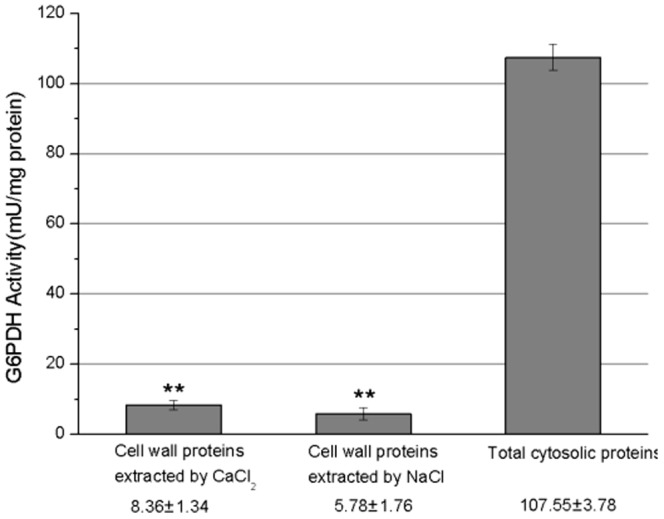
Evaluation of purity by the G6PDH activity in the cell wall proteins isolated from the roots of Elsholtzia splendens.The activity of G6PDH was assayed in CaCl2-extracted cell wall proteins, NaCl-extracted cell wall proteins and total soluble proteins. One unit of G6PDH activity is defined as 1 µmol of NADPH turnover per min/mg protein. Results are presented as mean ±SE of G6PDH activity from three biological replicates. The asterisks indicate significant differences in the G6PDH activity of CaCl2-extracted cell wall proteins, NaCl-extracted cell wall proteins compared with that of total soluble cytosolic proteins (**p<0.01).